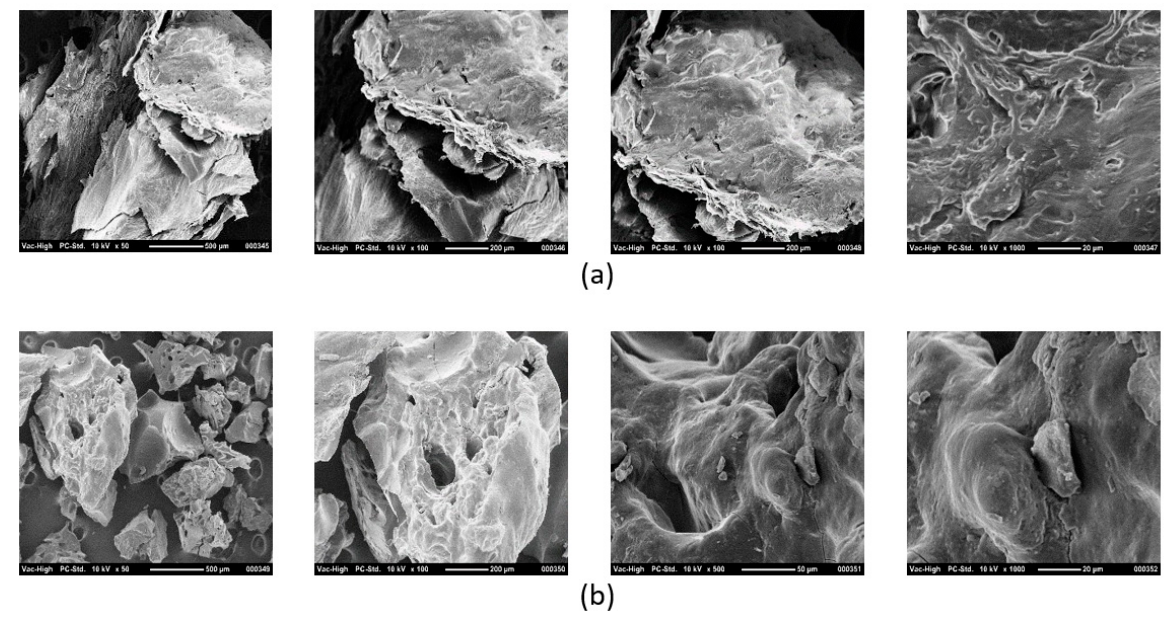
Figure 9. Cross-section SEM images of ( a ) fresh puffed rice samples and ( b ) puffed rice samples treated with sodium hydroxide.